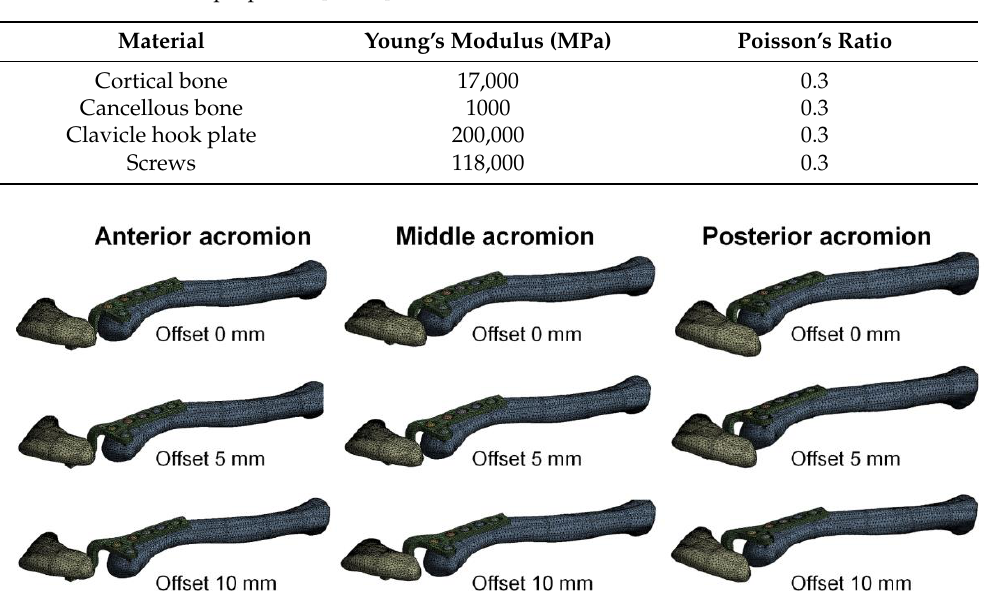
Figure 4. The loading conditions and boundary conditions in this study.